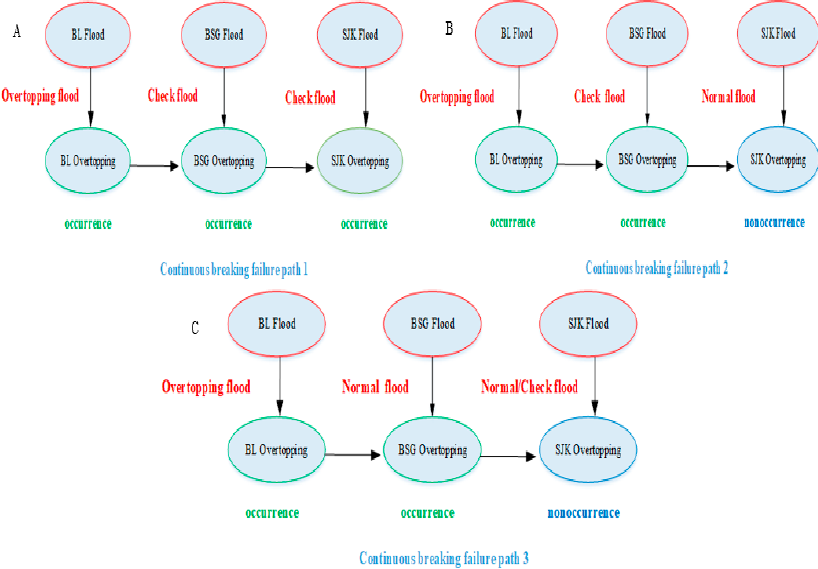
Figure 22. ( A ) The continuous breaking failure path 1, ( B ) the continuous breaking failure path 2, and ( C ) the continuous breaking failure path 3.